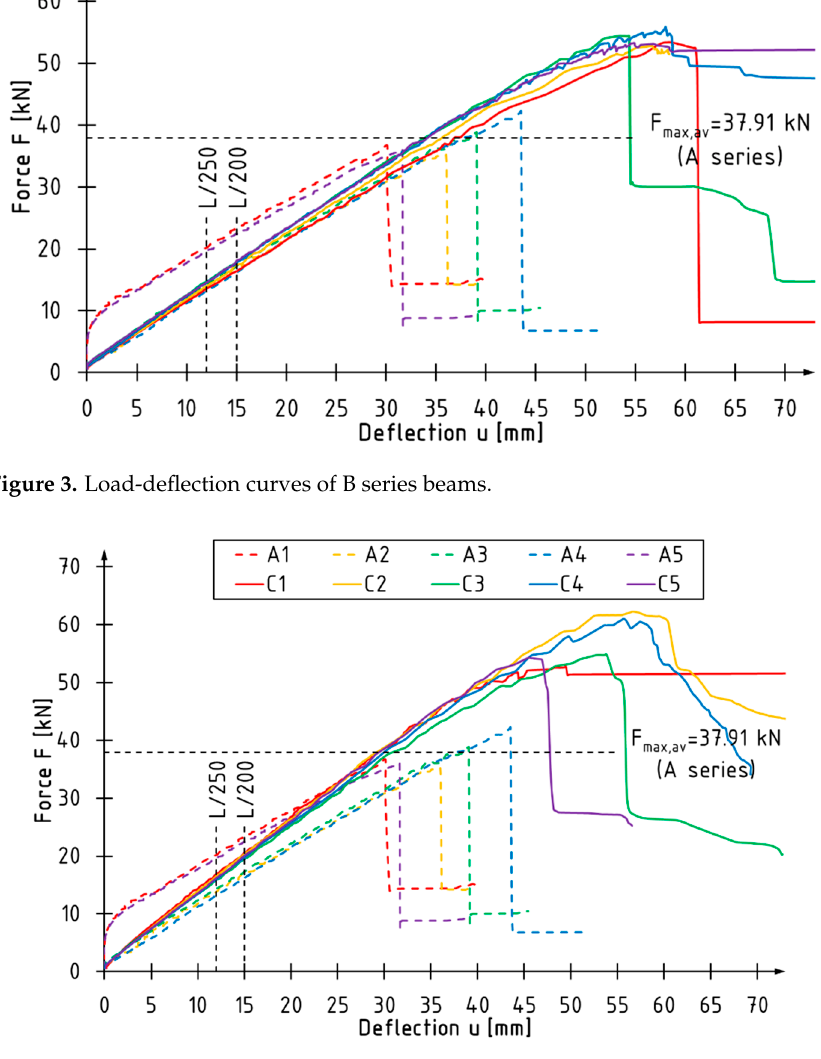
Figure 4. Load-deflection curves of C series beams.